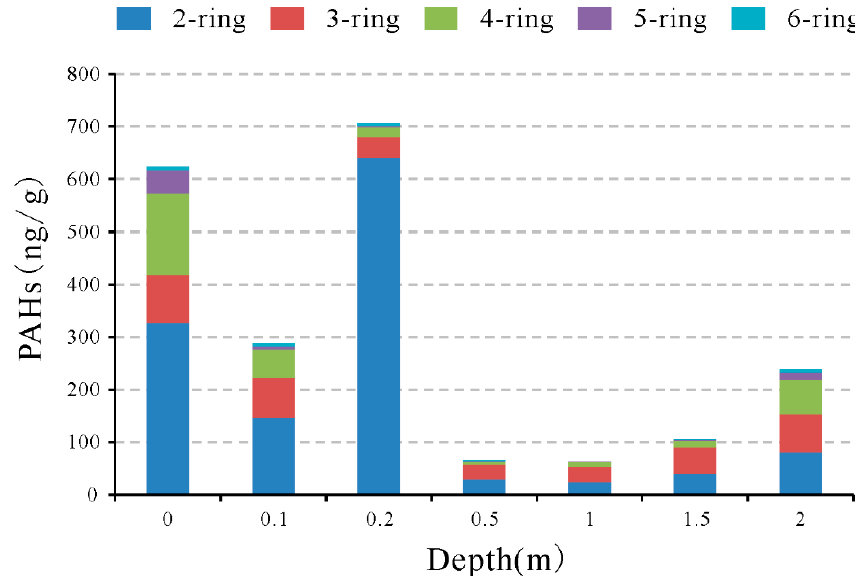
Figure 5. Concentration of PAHs vs. depth in the underground soils from borehole B1, according to ring number.